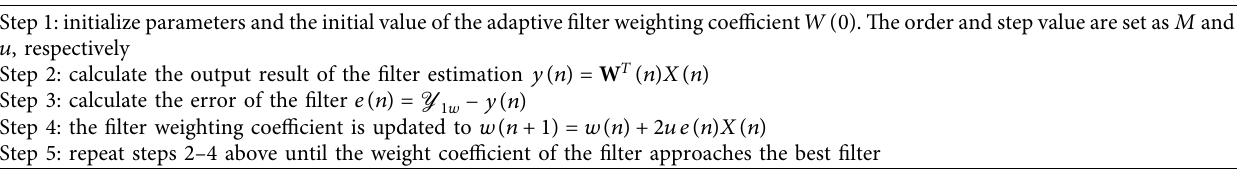
Figure 3: Te structure of the adaptive flter. Table 1: Te LMS algorithm.